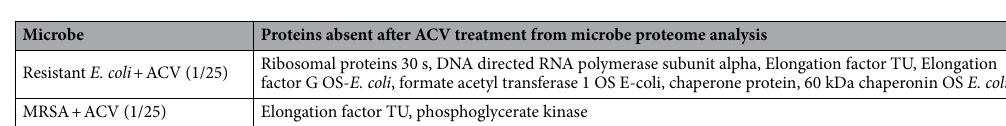
Table 3. List of E. coli proteins identified following ACV treatment. E. coli were cultured with 1/25 dilution of ACV or alone in broth for 24 h at 37 °C in a shaking incubator. Proteins were extracted, digested and subsequently analysed using ultra high performance liquid chromatography with high resolution mass spectrometry. The proteome for each organism was detected and the absence of proteins following 24 h of ACV treatment were identified using Proteome Discoverer software and tabulated. Data represent the repeats of 12 such experiments.